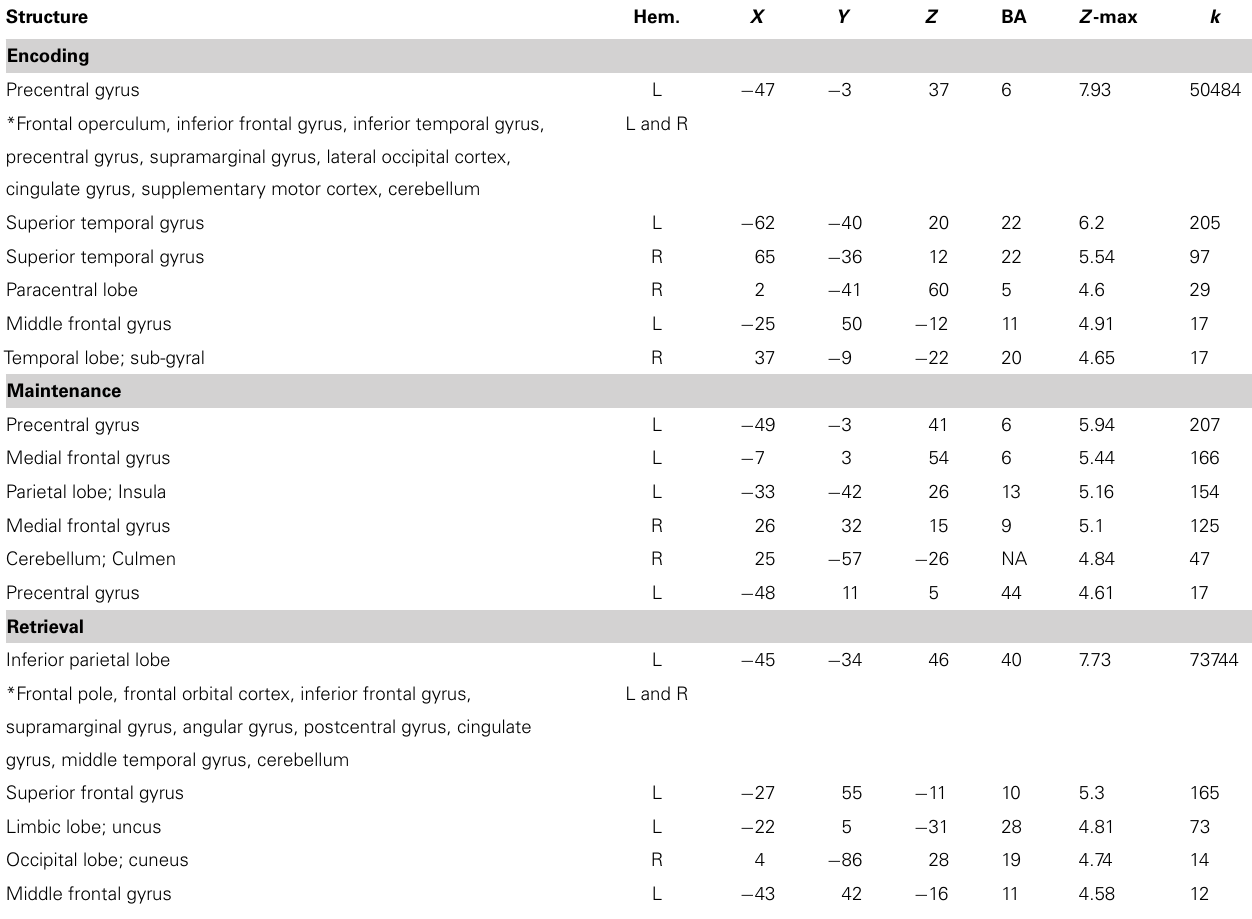
Table 1 | Global Z -max values andTalairach coordinates for areas active when comparing verbal versus baseline for encoding, maintenance, and retrieval. Structure Hem. X Y Z BA Z